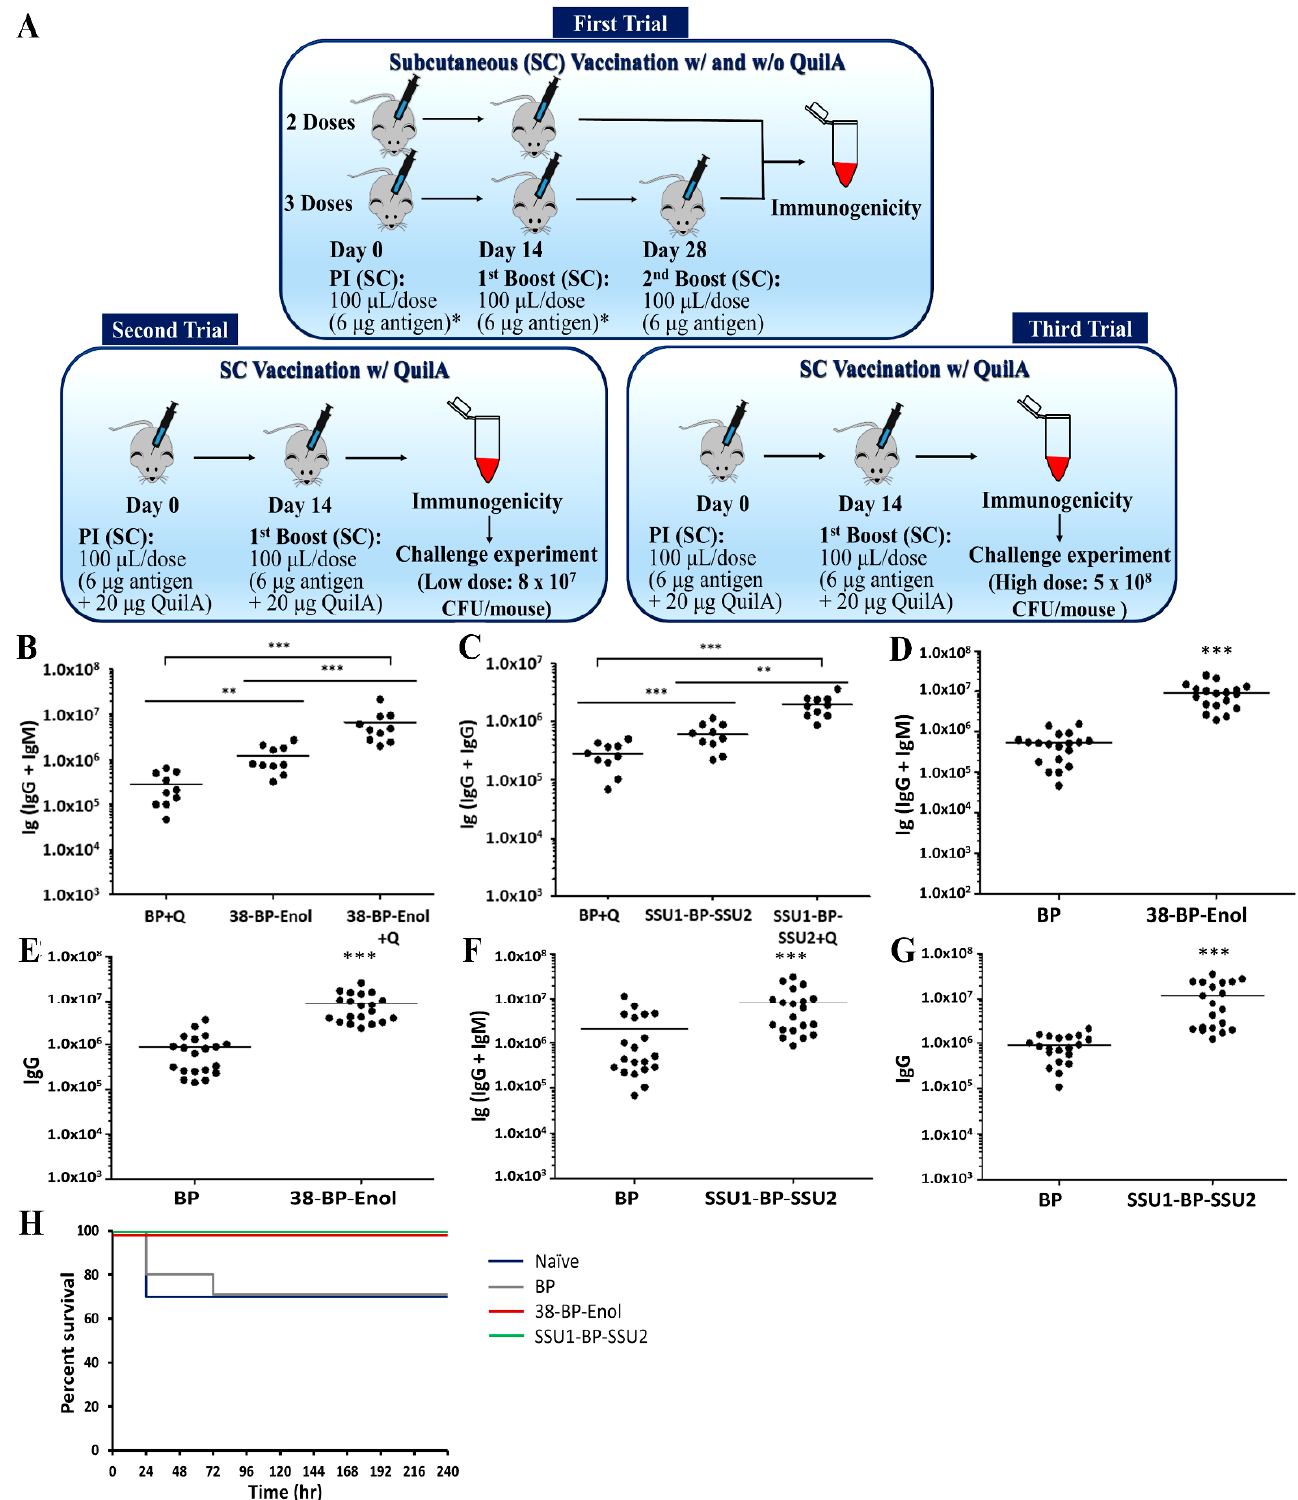
Figure 3. Immunological analysis and challenge of mice vaccinated with biopolymer particles (BPs) displaying S. suis antigens. ( A ) Schematic overview of the three animal trials. * With and without 20 µg/dose Quil-A®. ( B , C ) Results from the first animal trial. ( B ) Ig [IgG + IgM] response induced by 38-BP-Enol vaccination. ( C ) Ig [IgG + IgM] response induced by SSU-BP-SSU vaccination. Mice (n = 10) were immunized with two doses of 38-BP-Enol (6 µg/dose) and SSU1-BP-SSU2 (6 µg/dose) with adjuvant Quil-A® (Q) or without adjuvant. BP + Q control mice received two doses of empty BPs + Quil-A ® . Sera (day 28) from BP + Q or two-dose vaccination (38-BP-Enol or 38-BP-Enol + Q, SSU1-BP-SSU2, or SSU1-BP-SSU2 + Q) were analyzed by ELISA using either BP or 38-BP-Enol or SSU1-BP-SSU2 as coating antigen. Each dot represents a